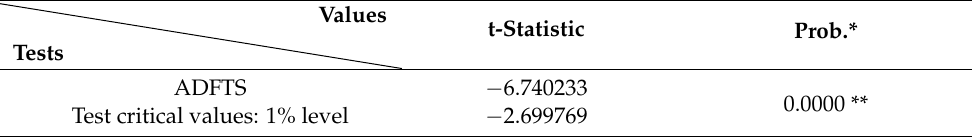
Figure 8. Residual sequence trend diagram of actual value and theoretical value (A and B variables). Table 8. Residual unit root test results of actual and theoretical values (A and B variables).